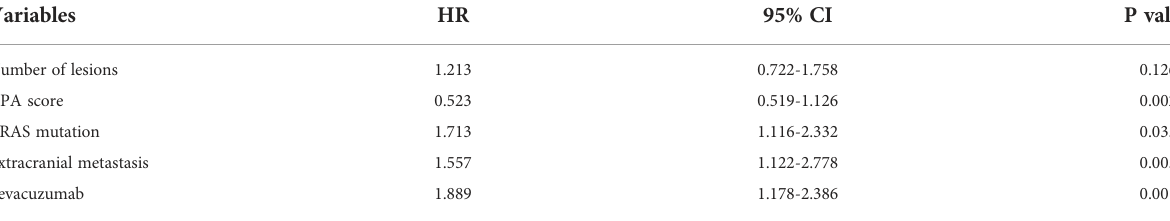
TABLE 3 Multivariate analysis of variables predictive of